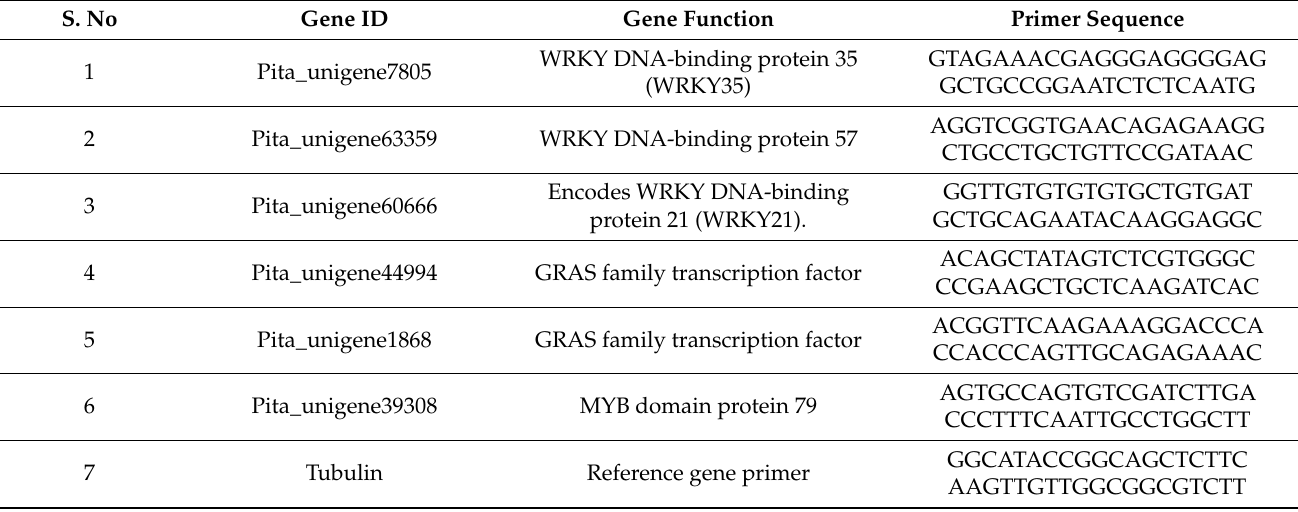
Figure 9. Regulation of transcript abundance related to the ABA biosynthesis pathway. Expression differences of the PtNCED3 genes between control, under drought, and recovery stages. (C: control, D: Drought, R: Rewatering). Table 1. Differentially expressed genes selected for gene expression analysis by